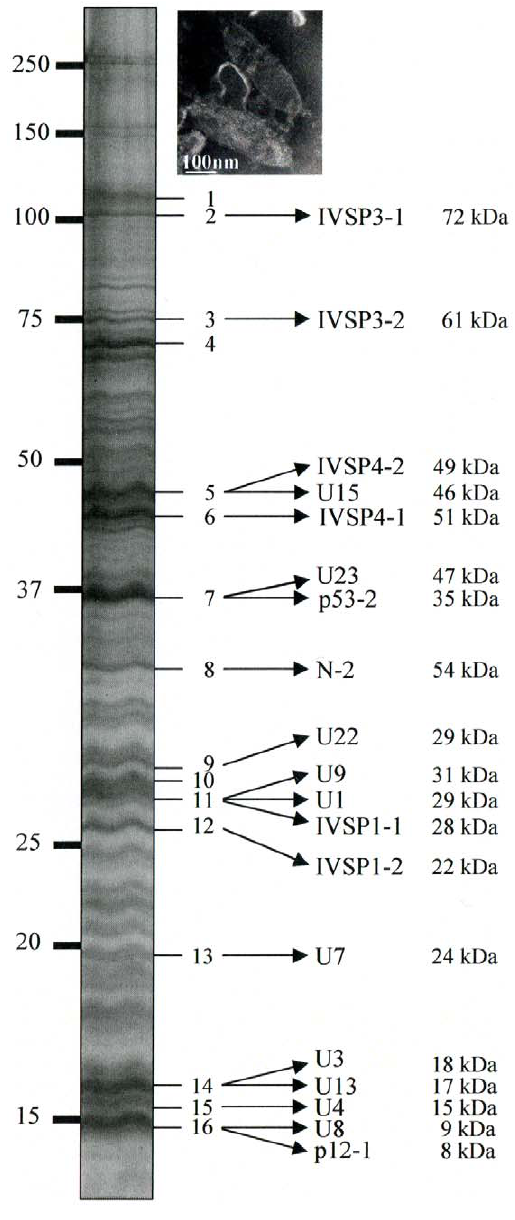
Figure 2. HdIV particle proteins identified by mass spectrom- etry and sequence searches using the translated sequences of the three IVSPER genes (16 bands were analyzed). Names and predicted molecular masses (see Table S3) of IVSPER proteins are shown beside the bands. Upper right panel shows a negative staining of HdIV